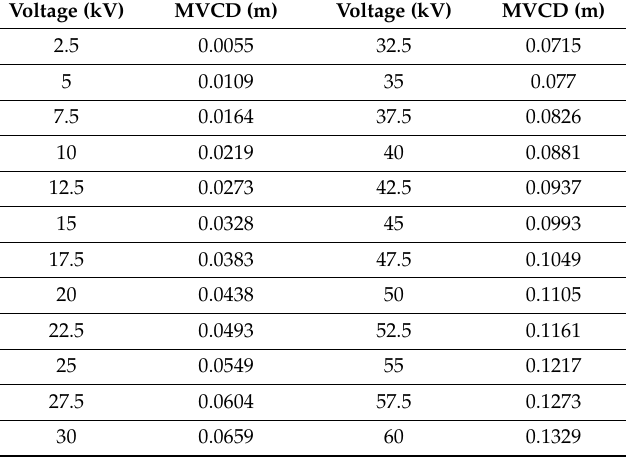
Table 1. Minimum vegetation clearance distance (MVCD) by the Gallet equation for different low DC voltages.